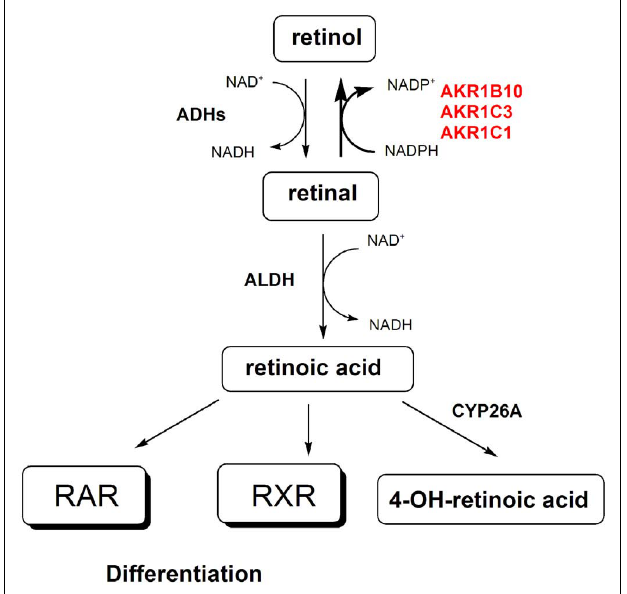
FIGURE 2 |The implications ofAKR1B andAKR1C enzymes in retinoid signaling. AKR1B10, AKR1C3, and AKR1C1 catalyze the reduction of all- trans -retinal and 9- cis -retinal to their corresponding retinols, respectively. The reverse reaction is catalyzed by alcohol dehydrogenases (ADHs). Retinal is further oxidized by aldehyde dehydrogenases (ALDHs) to form retinoic acid, which by binding to the retinoic acid receptor (RAR) and the retinoid X receptor (RXR) stimulates cell differentiation. Retinoic acid is further metabolized by CYP26A to form 4-hydroxy-retinoic acid. Increased levels of AKR1B10 and AKR1C3 might be linked to depletion of retinoic acid, which deprives RAR and RXR of their ligands, and thus blocks cell differentiation.